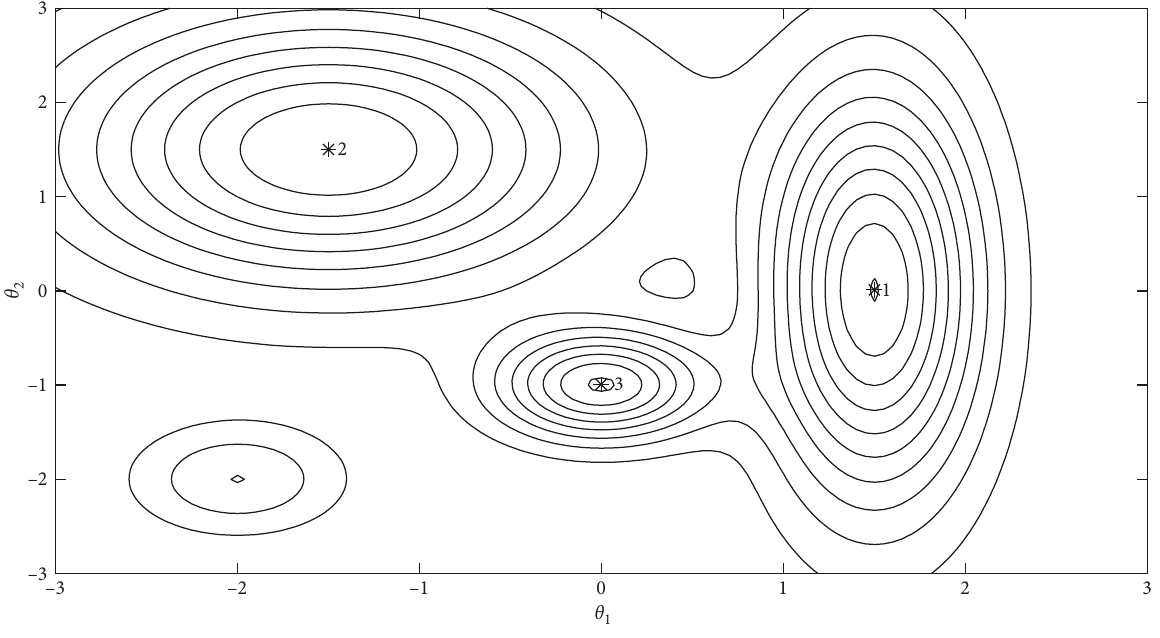
Figure 8: Multi-solutions after the cut method. Table 1: Multi-solutions after the cut